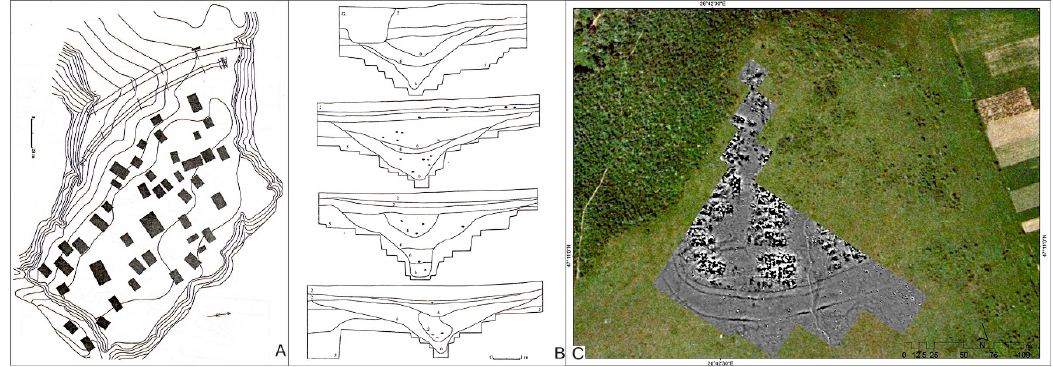
Figure 15. ( A ) The layout of H ă b ăș e ș ti, Holm [9] archaeological site with two ditches closing the open side of settlement; ( B ) Cross-sections through the outer ditch from H ă b ăș e ș ti, Holm [9]; ( C ) Magnetic map ( − 10 to +10 nT, white/black) from Br ă te ș ti, Chicerea [15] showing a similar defensive system composed from two large parallel ditches and a third narrower one.